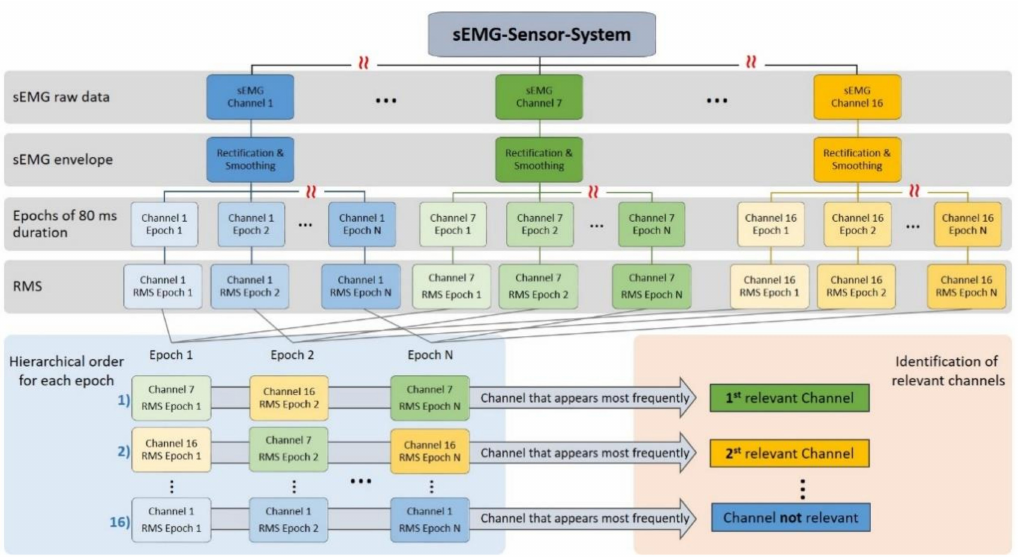
Figure 4. Block diagram of the algorithm for identifying the sEMG channels that best reflect muscle activation: the relevant sEMG